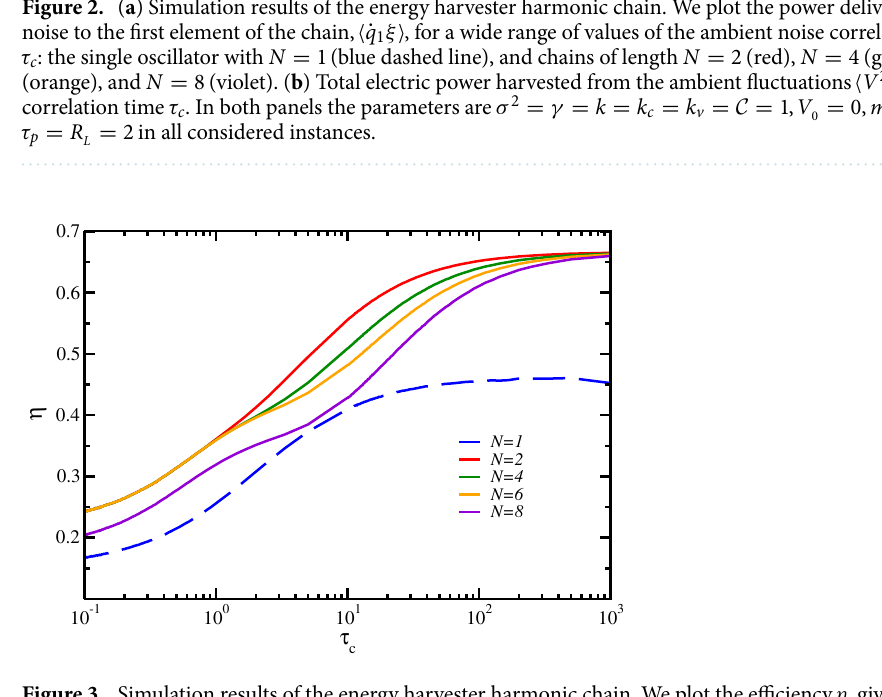
Figure 3. Simulation results of the energy harvester harmonic chain. We plot the efficiency η , given by Eq. (9), versus ambient noise correlation time τ c . Efficiency of the energy harvester measures the ratio between the power delivered by the noise and the net electric power generated by the device. The system sizes, parameter values, and color coding as in Fig.